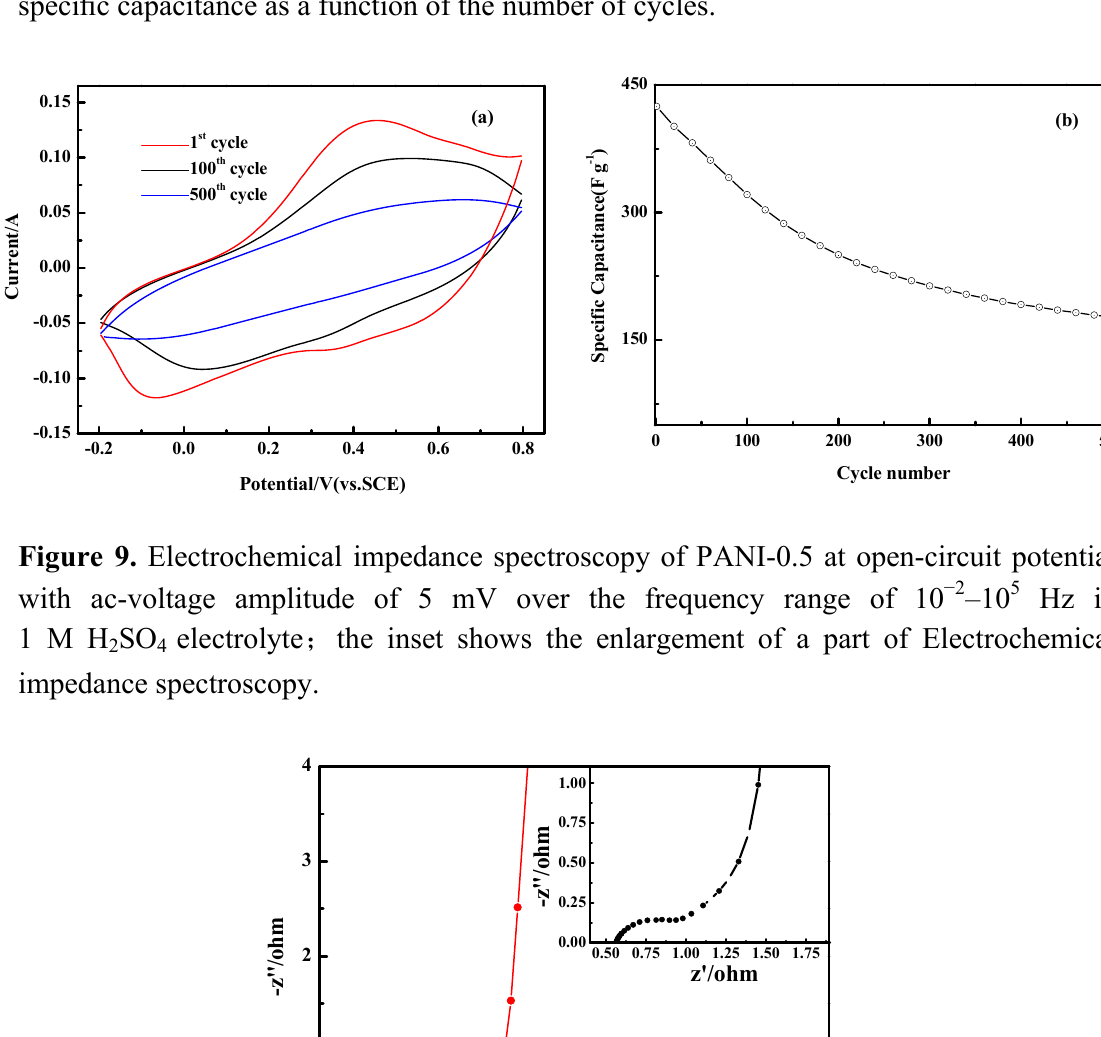
Figure 8. ( a ) CV curves for the PANI-0.5 electrode for the 1st, 100th and 500th cycle from stability studies using 1 M H SO electrolyte solution at 50 mV . s − 1 ; ( b ) Variation in the 2 4 speci fi c capacitance as a function of the number of cycles.